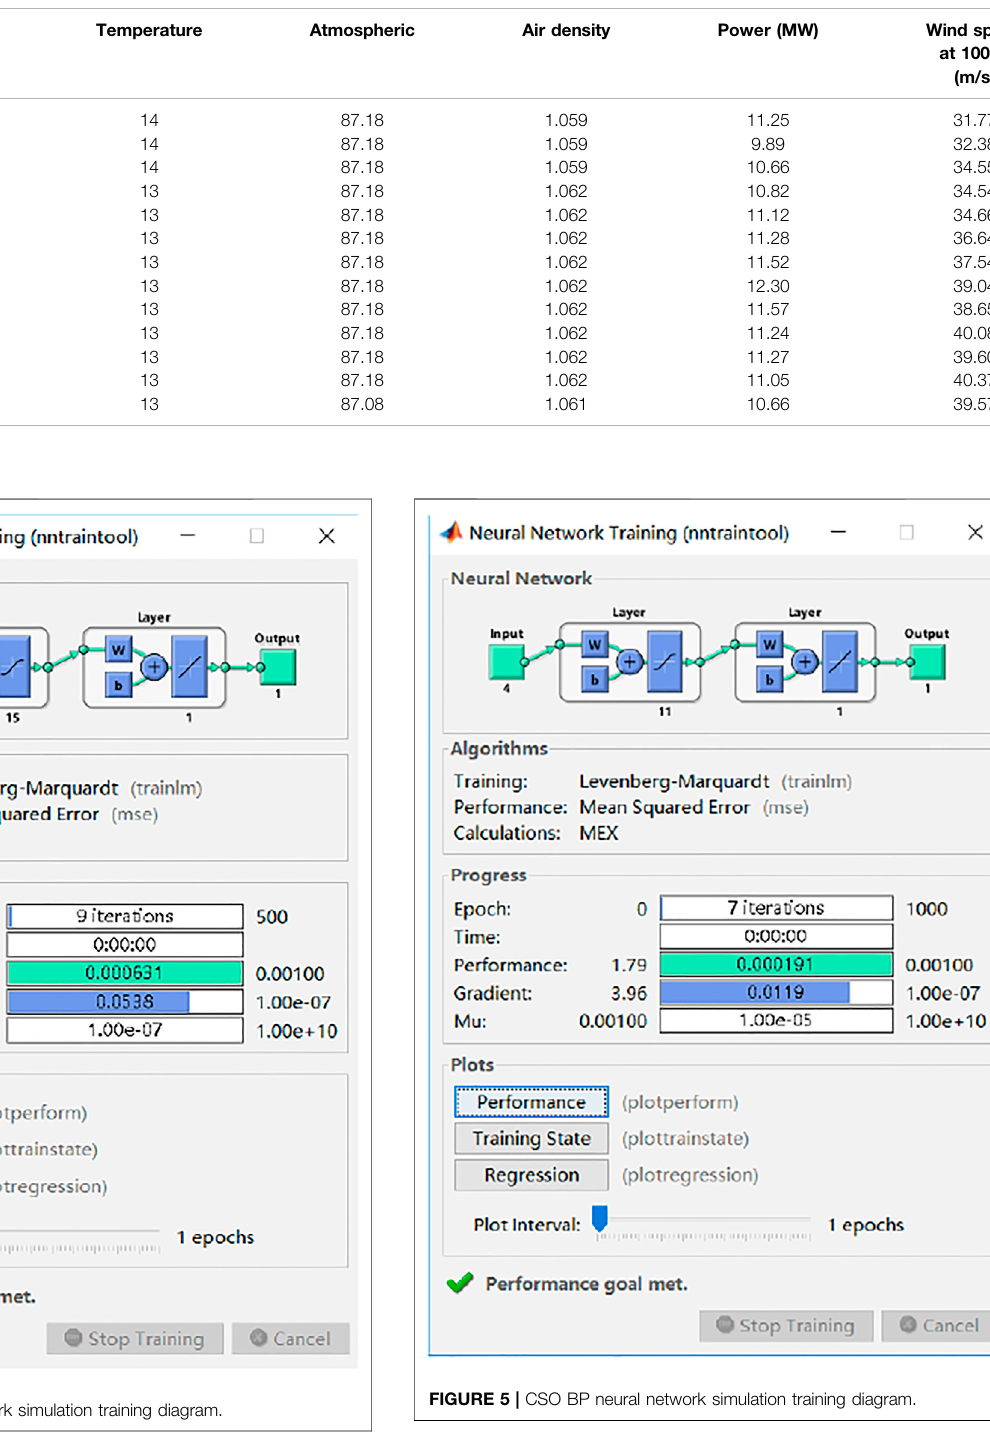
TABLE 1 | Some wind farm parameters.